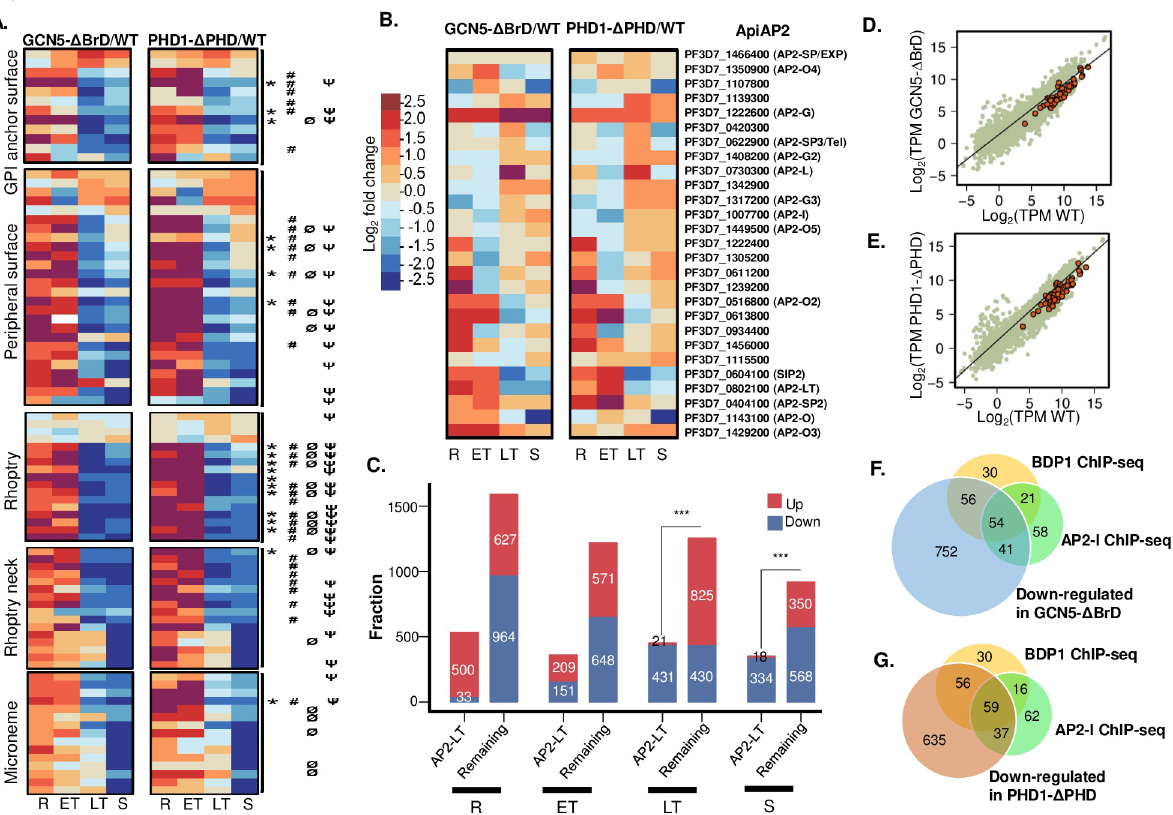
Fig 6. Down-regulation of invasion-related pathway and alteration of AP2 genes in domain deletion mutants. (A) Heatmaps displaying down- regulation of genes involved in the invasion of the RBC in the two deletion mutants. � and # indicate the AP2-I and putative AP2-LT target genes, respectively. Ø and C indicate the down-regulated genes upon knockdown of BDP1 and the target genes identified by BDP1-HA ChIP-seq analysis, respectively. (B) Heatmaps showing altered expression of the AP2 genes in the deletion mutants. (C) Putative AP2-LT target genes (with AP2-LT binding motifs) are significantly enriched in the down-regulated genes in PfGCN5- Δ BrD::GFP at the late stages. The numbers of up- and down- regulated genes upon PfGCN5 BrD domain deletion are shown as the red and blue bars at four developmental stages. These altered genes were further classified as the putative target genes of AP2-LT and the remaining genes. R, ring; ET, early trophozoite; LT, late trophozoite; S, schizont. ��� , P < 0.001 (Fisher’s exact